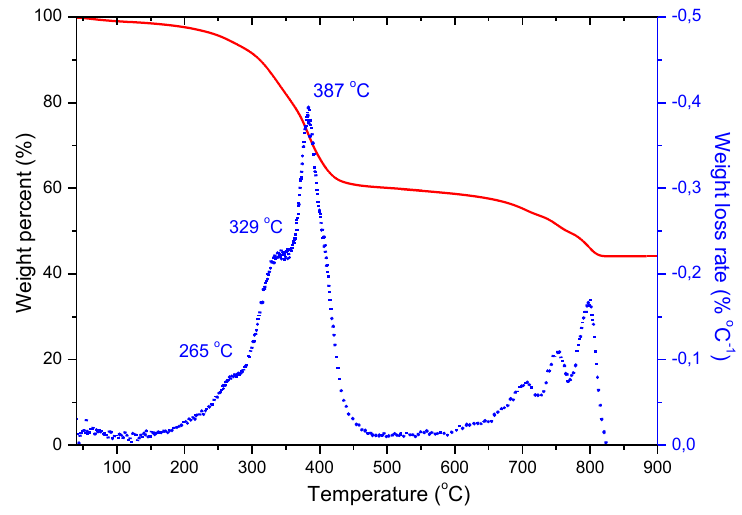
Figure 6. Thermogram of the magnetic nanoparticles.